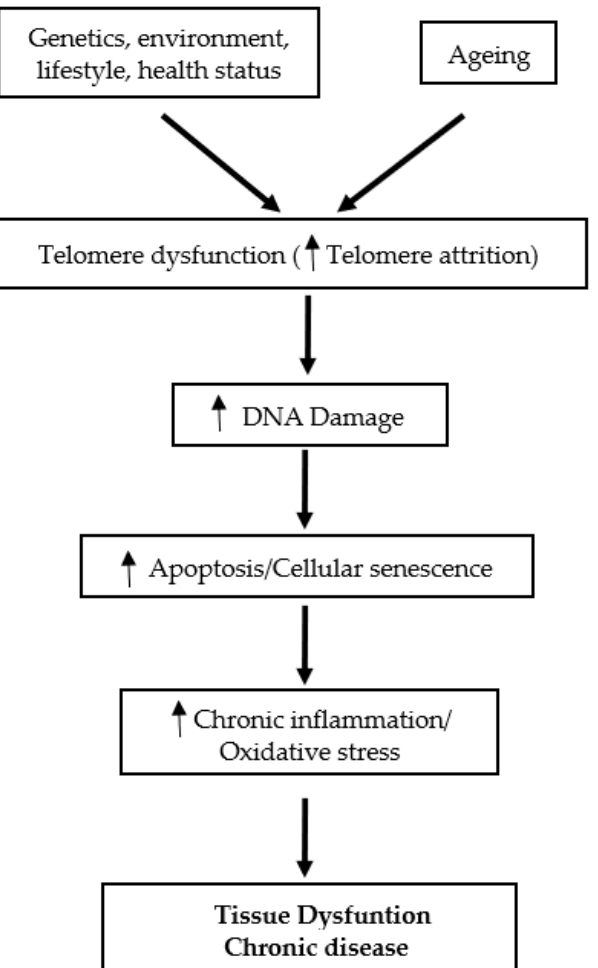
Figure 1. Schematic overview of the role of telomeres in tissue dysfunction and chronic disease. Evidence from animal models as well as human studies have demonstrated that various nutrients (e.g., folate, niacin, vitamin C, magnesium, zinc and omega-3 fatty acids), bioactives (e.g., polyphenols) and whole foods (e.g., tea) may influence telomere length and telomere attrition through mechanisms related to cellular functions including DNA repair and chromosome maintenance, DNA methylation, inflammation, oxidative stress and telomerase activity I (For review see [7]). Vitamin D may influence telomere length through its biologically active hormone 1 α ,25 dihydroxyvitamin D3 (calcitriol) [8]. Calcitriol is a potent immunosuppressant and has strong anti-inflammatory and anti-proliferative properties mediated in part by its ability to reduce gene expression of